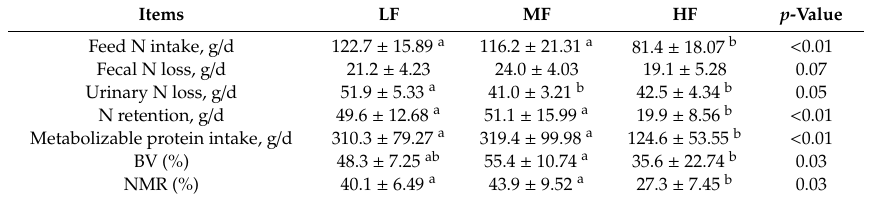
Table 4. Nitrogen balance in adult donkeys fed low- (LF, F / C = 35:65), medium- (MF, F / C = 55:45) and high-fiber (HF, F / C = 80:20) diets with di ff erent forage / concentrate ratio (F / C).